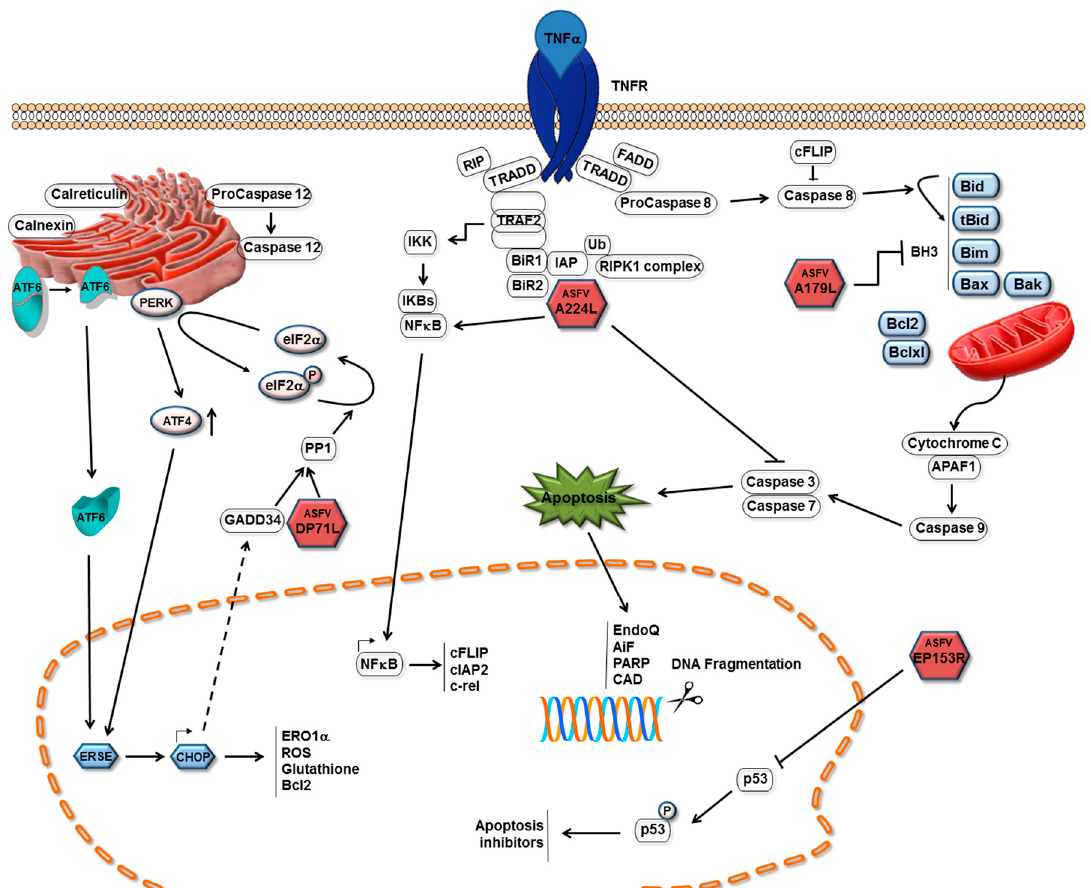
Figure 1. Mechanisms of apoptosis inhibition by African swine fever virus (ASFV). Pathways by which ASFV inhibits induction of apoptosis in infected cells and ASFV proteins are shown as red hexagons with the name of the protein inside. The ASFV A179L Bcl-2 family protein binds to and inhibits several BH3 only domain pro-apoptotic proteins. The A224L IAP-family protein binds to and inhibits caspase 3 and activates nuclear factor kappa-light-chain-enhancer of activated B cells (NF- κ B) signalling, thus increasing expression of anti-apoptotic genes including cFLIP , cIAP2 and c-rel . The DP71L protein recruits protein phosphatase 1 to dephosphorylate eIF2a, restoring global protein synthesis and inhibiting transcriptional activation of pro-apoptotic CCAAT-enhancer-binding protein homologous protein (CHOP). The EP153R protein inhibits activation of the p53 protein.